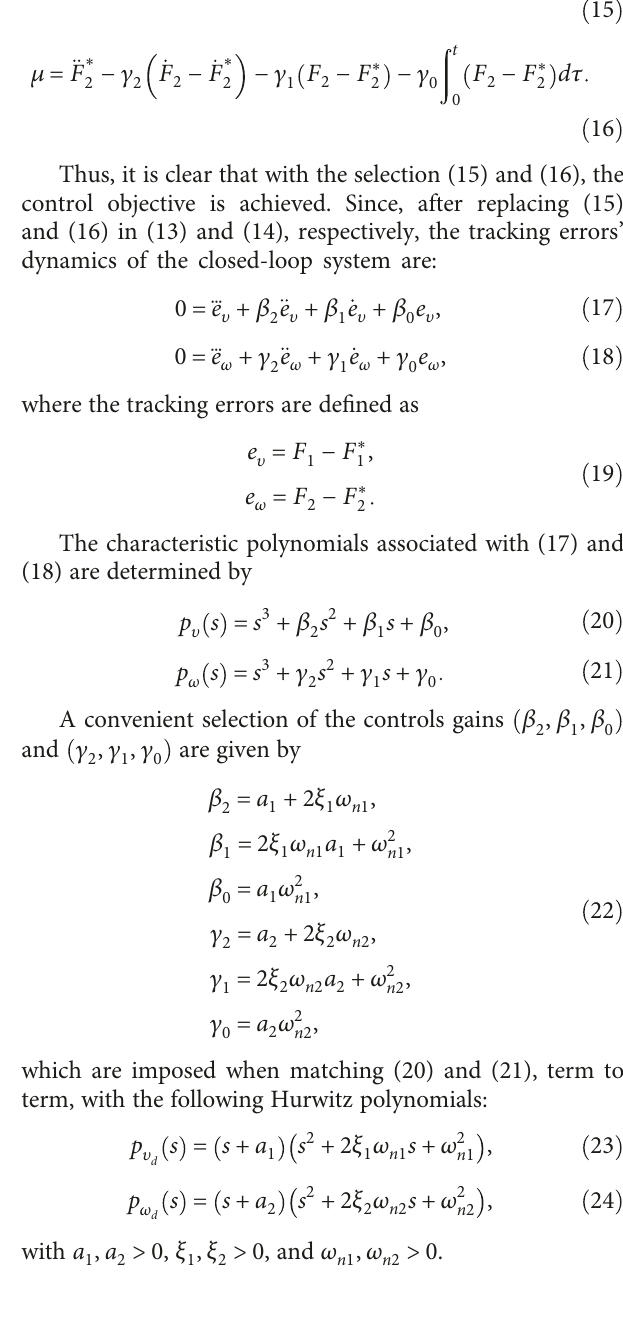
counterelectromotive force constant, k is the motor torque m constant, and b is the viscous friction coe ffi cient of the motor. Whereas u and u represent the system average con- 1av 2av ∈ 0, 1 and u ∈ − 1, 1 , trols, under the restrictions u 1av 2av